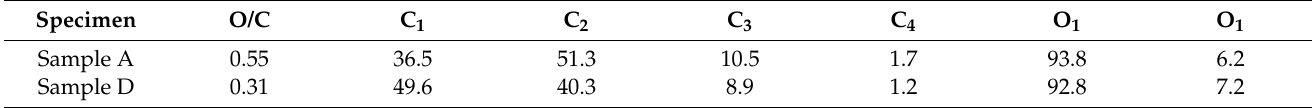
Table 2. Specific changes in the carbon and oxygen content of the thermally modified bamboo samples.